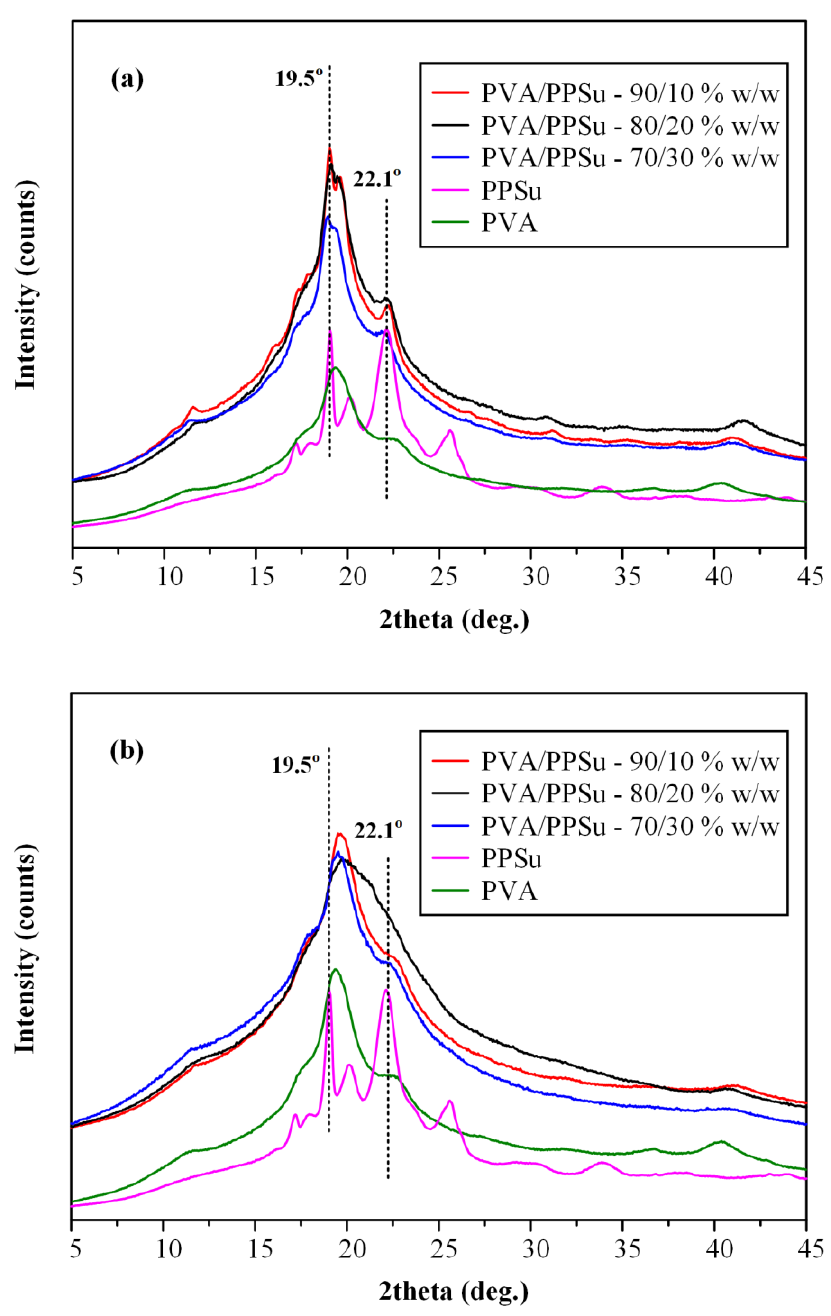
Figure 4. pXRD diffractograms of the raw materials (PVA and PPSu), as well as the neat PVA/PPSu matrices prepared after 3 min ( a ) and 10 min ( b ) of melt-mixing.